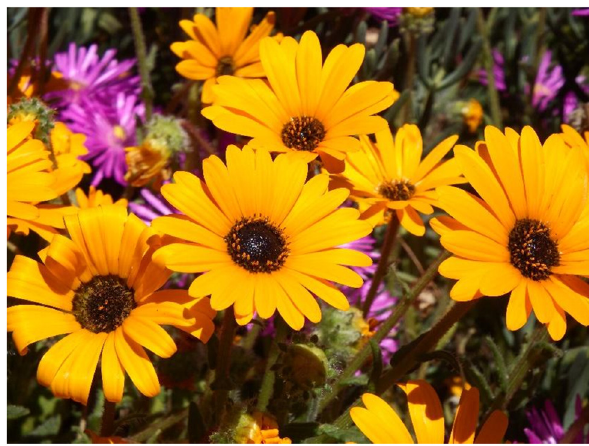
Figure 1: : Arctotis hirsuta ( source: Roger Oliver ) 1/10/2013: Kleinmond 34.3392417S 19.0177145E.